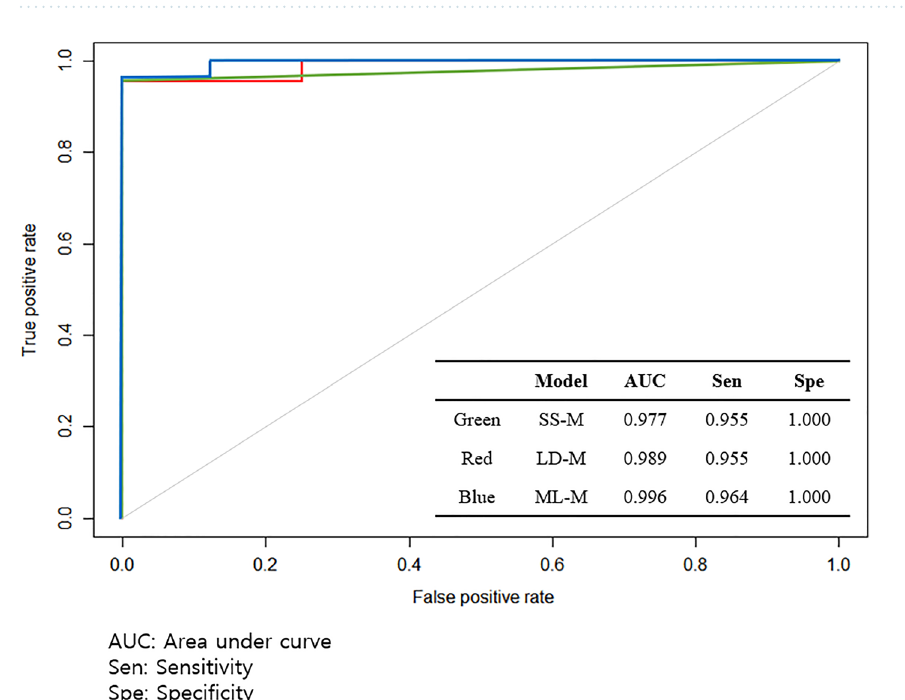
Figure 5. Receiver operating characteristic (ROC) curve of a diagnostic model using test set: SD-M: The model based on significant difference, LD-M: The model based on LEfSe analysis, and ML-M: The model based on machine learning